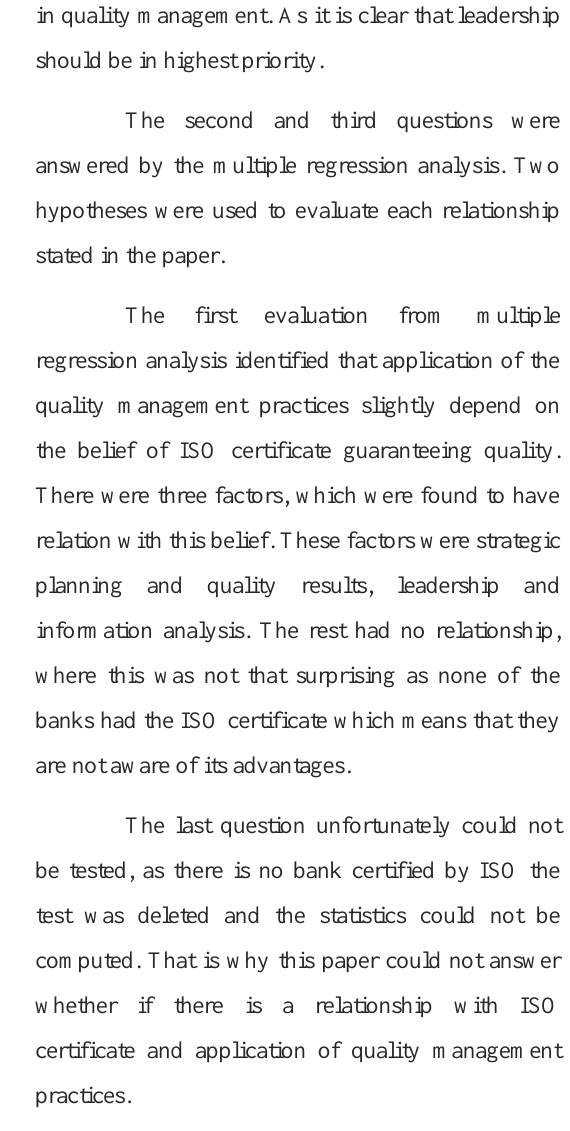
Table IV: Coefficients table for banks belief in ISO certificate guaranteeing